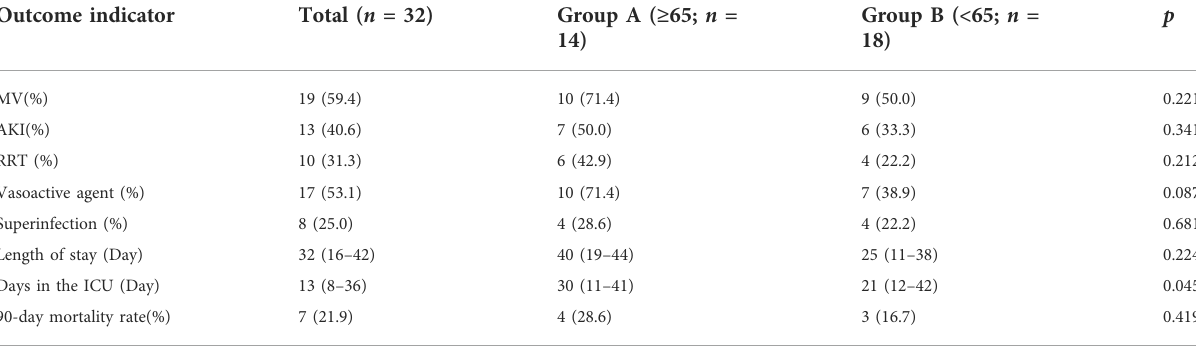
TABLE 3 Outcome measures in patients with abdominal sepsis in different age